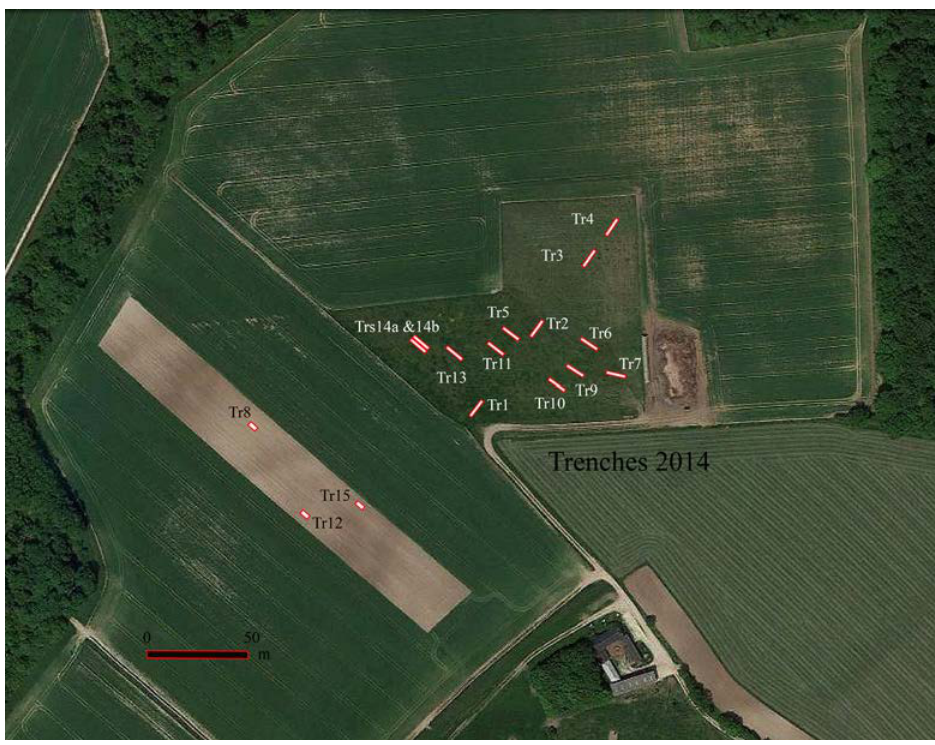
Fig. 6: Aerial image of the archaeological set-aside area and surrounding arable fields at Downley, showing the position of the 2014